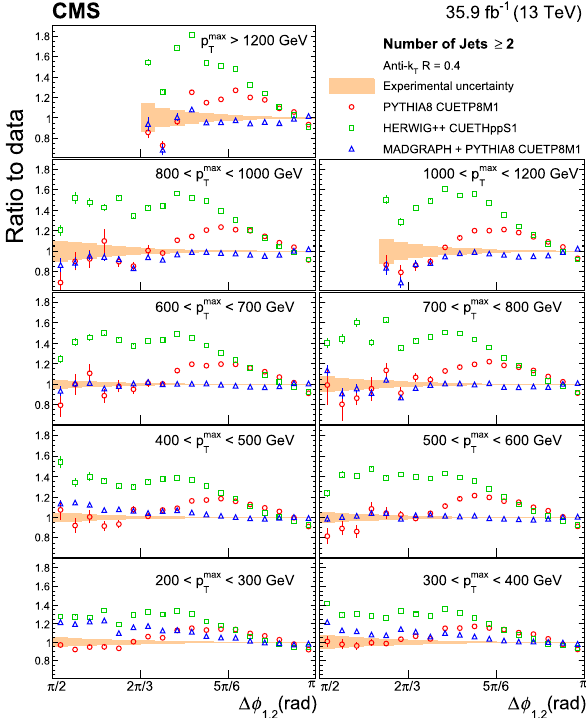
Fig. 3 Normalized inclusive 4-jet cross section differential in Δφ 1,2 for eight p max regions, scaled by multiplicative factors for presentation T purposes. The size of the data symbol includes both statistical and sys- tematic uncertainties. The data points are overlaid with the predictions from the ph- 2j + pythia 8 event generator